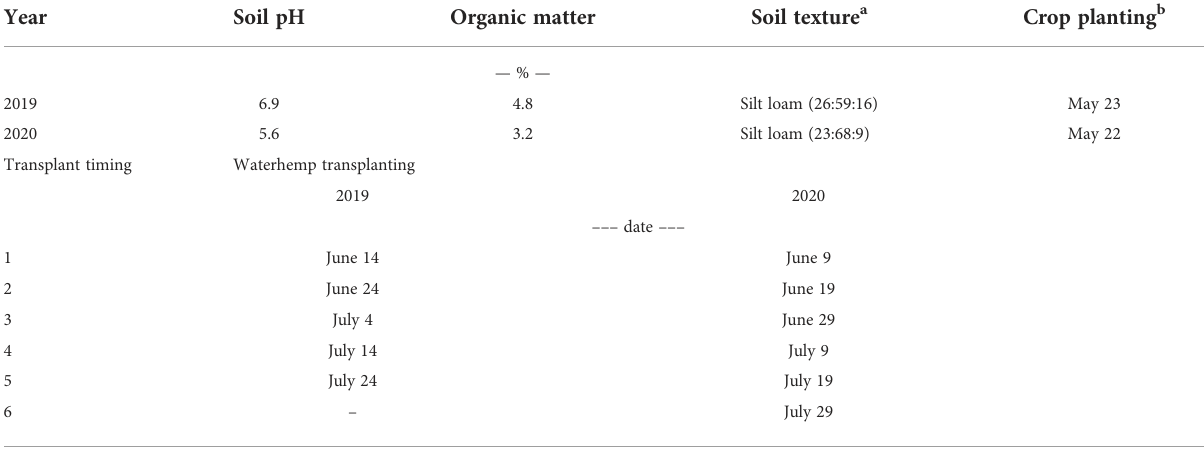
TABLE 1 Soil characteristics, crop management, and waterhemp transplant timings for the fi eld experiments in 2019 and 2020 at Arlington, Wisconsin.